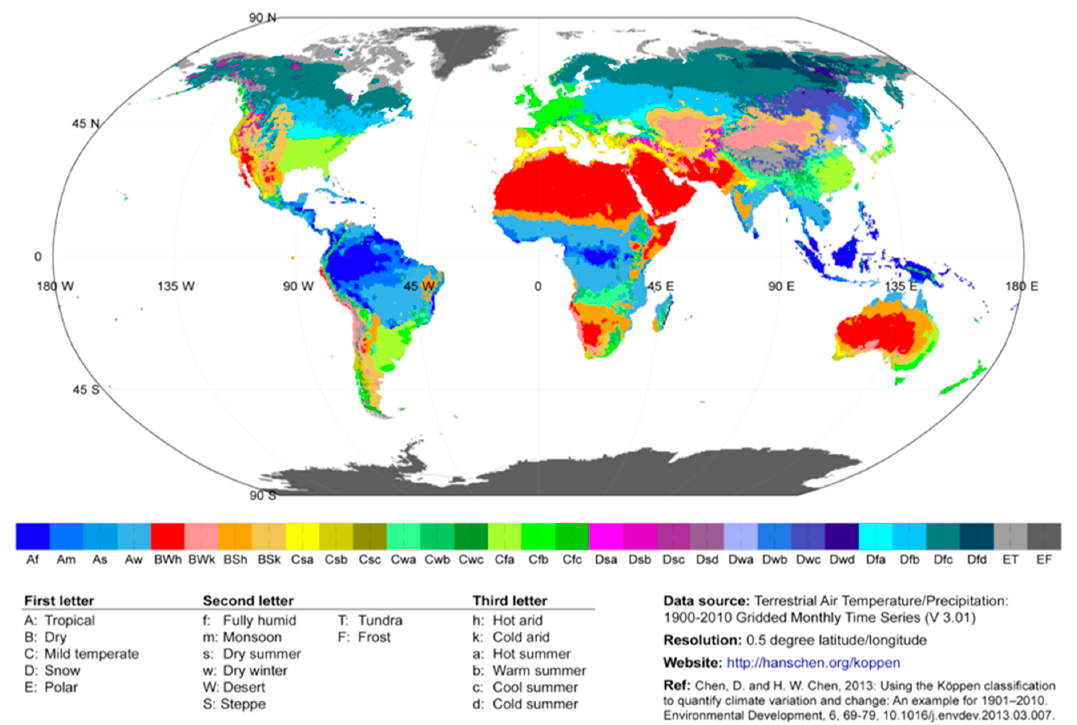
Figure 3. World map of the Koppen-Geiger climate classification system [18].